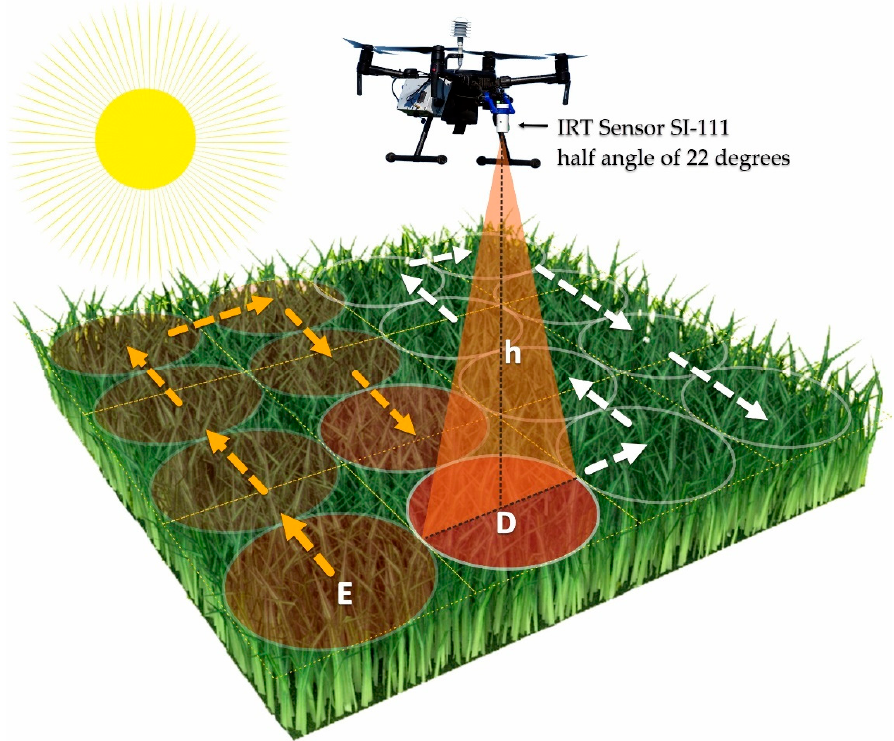
Figure 8. Graphic illustration of the measurement process with an infrared radiometer adapted to a UAV over dense cultivation foliage under a clear sky. The flight height depends on the sensor type and the characteristics of the crop. For a specific IRT sensor, the visible surface area is a function of height. For the sensor SI-111 that was placed vertically to the foliage with a height of flight h = 4 m, the surface area was E = 8.2 m 2 , and the diameter of the circular surface was about 3.2 m.